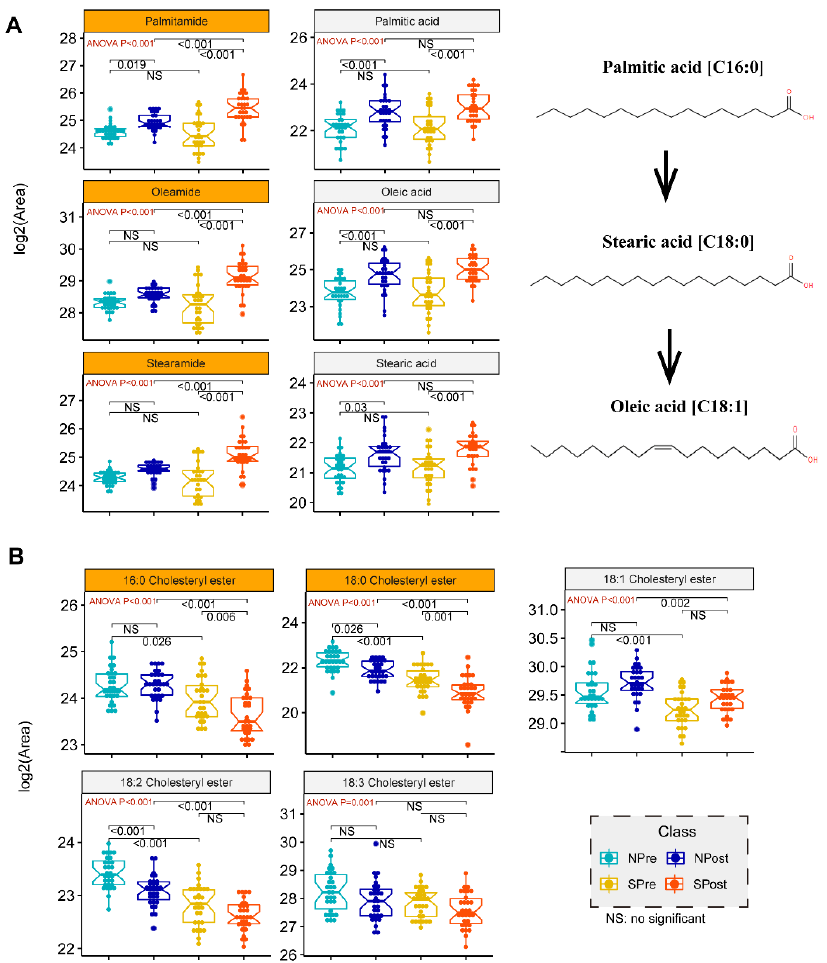
Figure 5. Box plot analysis for candidate signatures of amides or fatty acids. ANOVA with posthoc tests were used to determine the p values of pairwise comparison between groups. The corresponding p values are labelled in the top area of the figure. The red texts in the upper left corner are the p values of ANOVA tests, and the black texts in the top are the p values of Tukey post-hoc tests. The orange in the facet background indicates that this feature is one of the candidate signatures from the multistep machine learning workflow. ( A ) Schematic of palmitic, stearic and oleic acid biosynthetic pathways derived from KEGG pathway maps. ( B ) Box-and-whisker plot for the general trends of 5 cholesteryl esters.